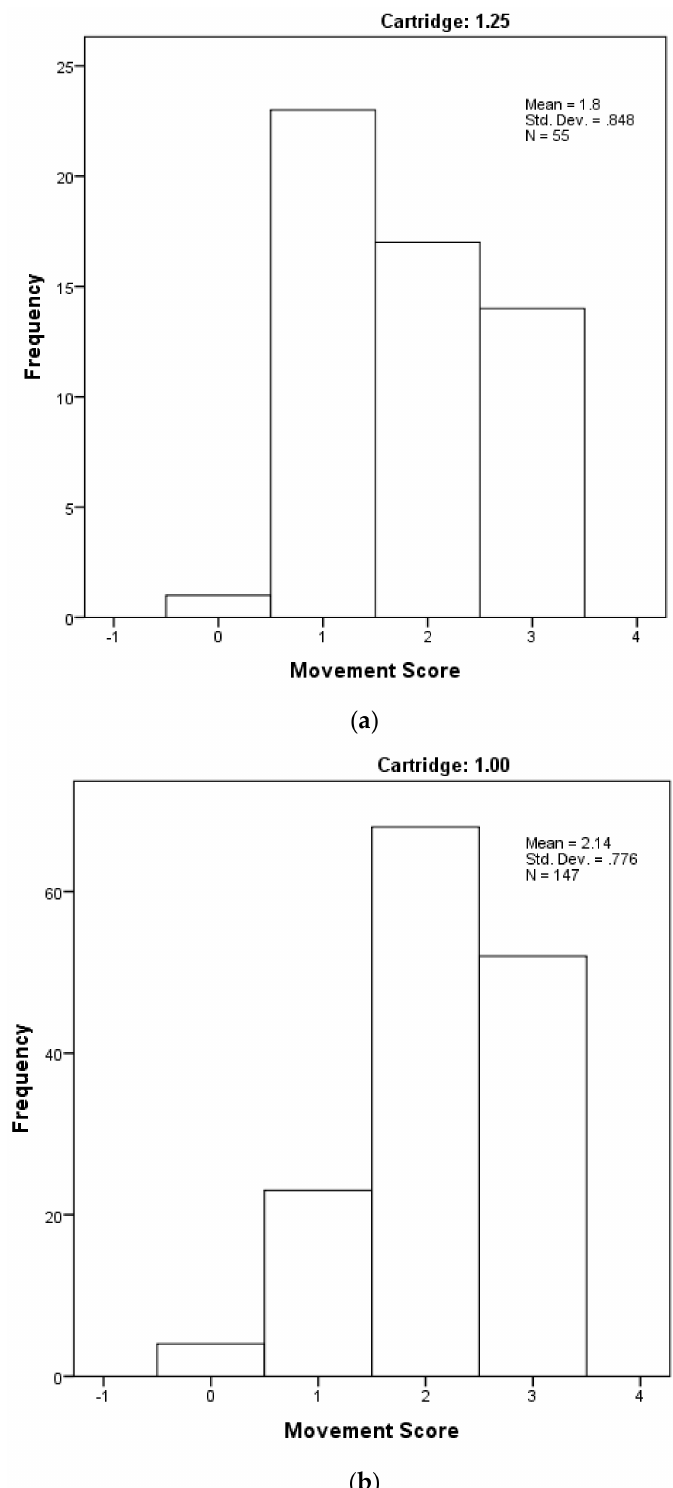
Figure 9. The distribution of piglet movement scores by cartridge-size used, based on a subjective scoring where Score 0 = very little movement; Score 1 = some mild uncontrolled physical movement of limbs; Score 2 = considerable uncontrolled physical movement of limbs; and Score 3 = gross uncontrolled physical movement. ( a ) with 1.25 grain cartridge and ( b ) with 1 grain